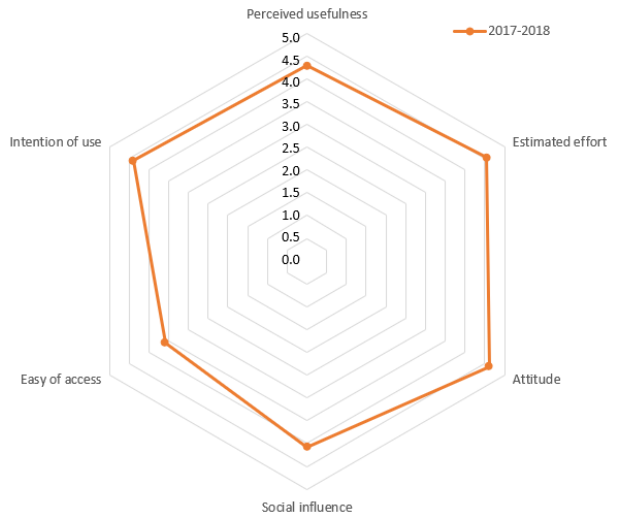
Figure 7. Evaluated indicators for the 2017–2018 academic